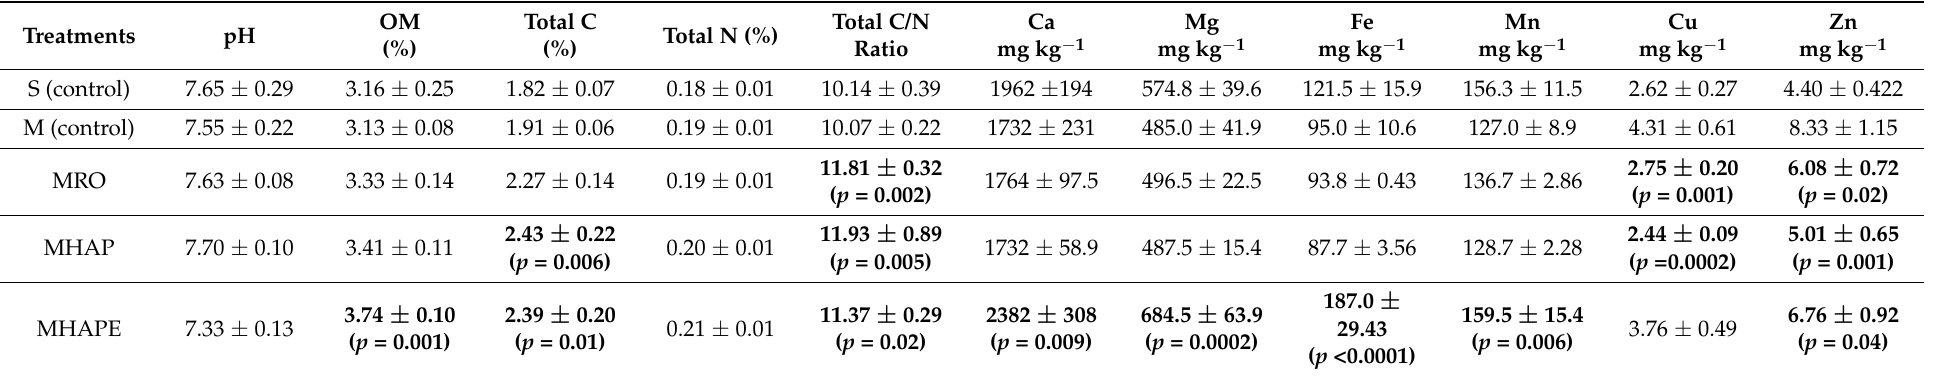
Table 4. Comparison between different treatments on soybean soil physicochemical properties and Mehlich3 (M3) extractable nutrients in pot study experiments. Values are given in mean +/ − standard deviation for n = 4 replicates. Values in parentheses represent p -values at 0.05 level, while bold values signify statistical significance to manure treatment (M).